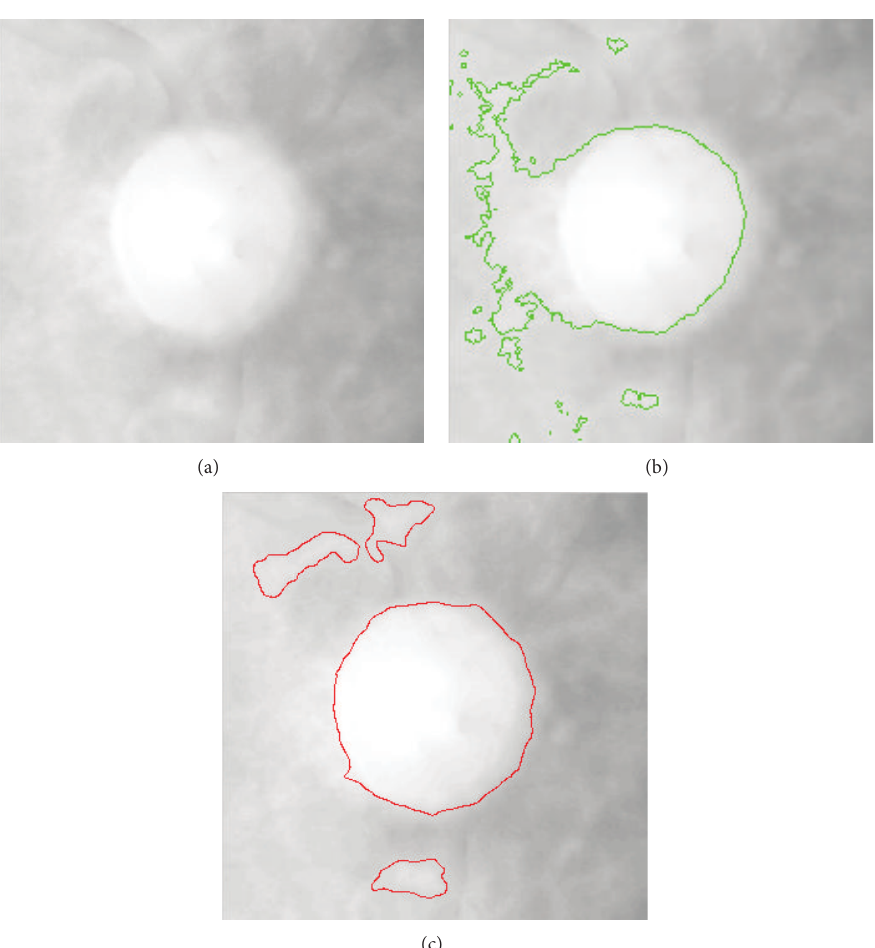
Figure 13: CV and local Gaussian distribution model. (a) Raw image. (b) CV model results. (c) Local Gaussian distribution model